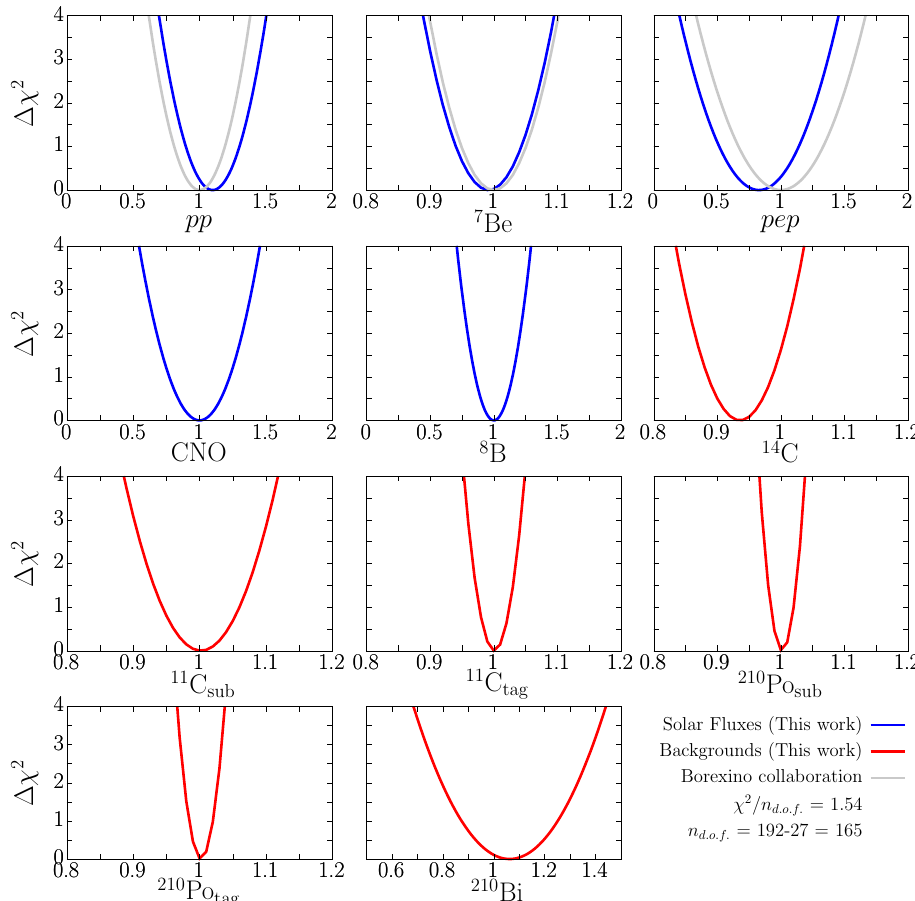
Figure 9 . Dependence of ∆ χ 2 of fit to the Borexino phase-II spectra on the normalization of the solar fluxes and the dominant backgrounds (normalized to the corresponding best fit normalizations of the fit of the Borexino collaboration in ref. [22]). For comparison we show as light blue curves the corresponding results of the determination of solar fluxes in ref. [22]) (see text for details).